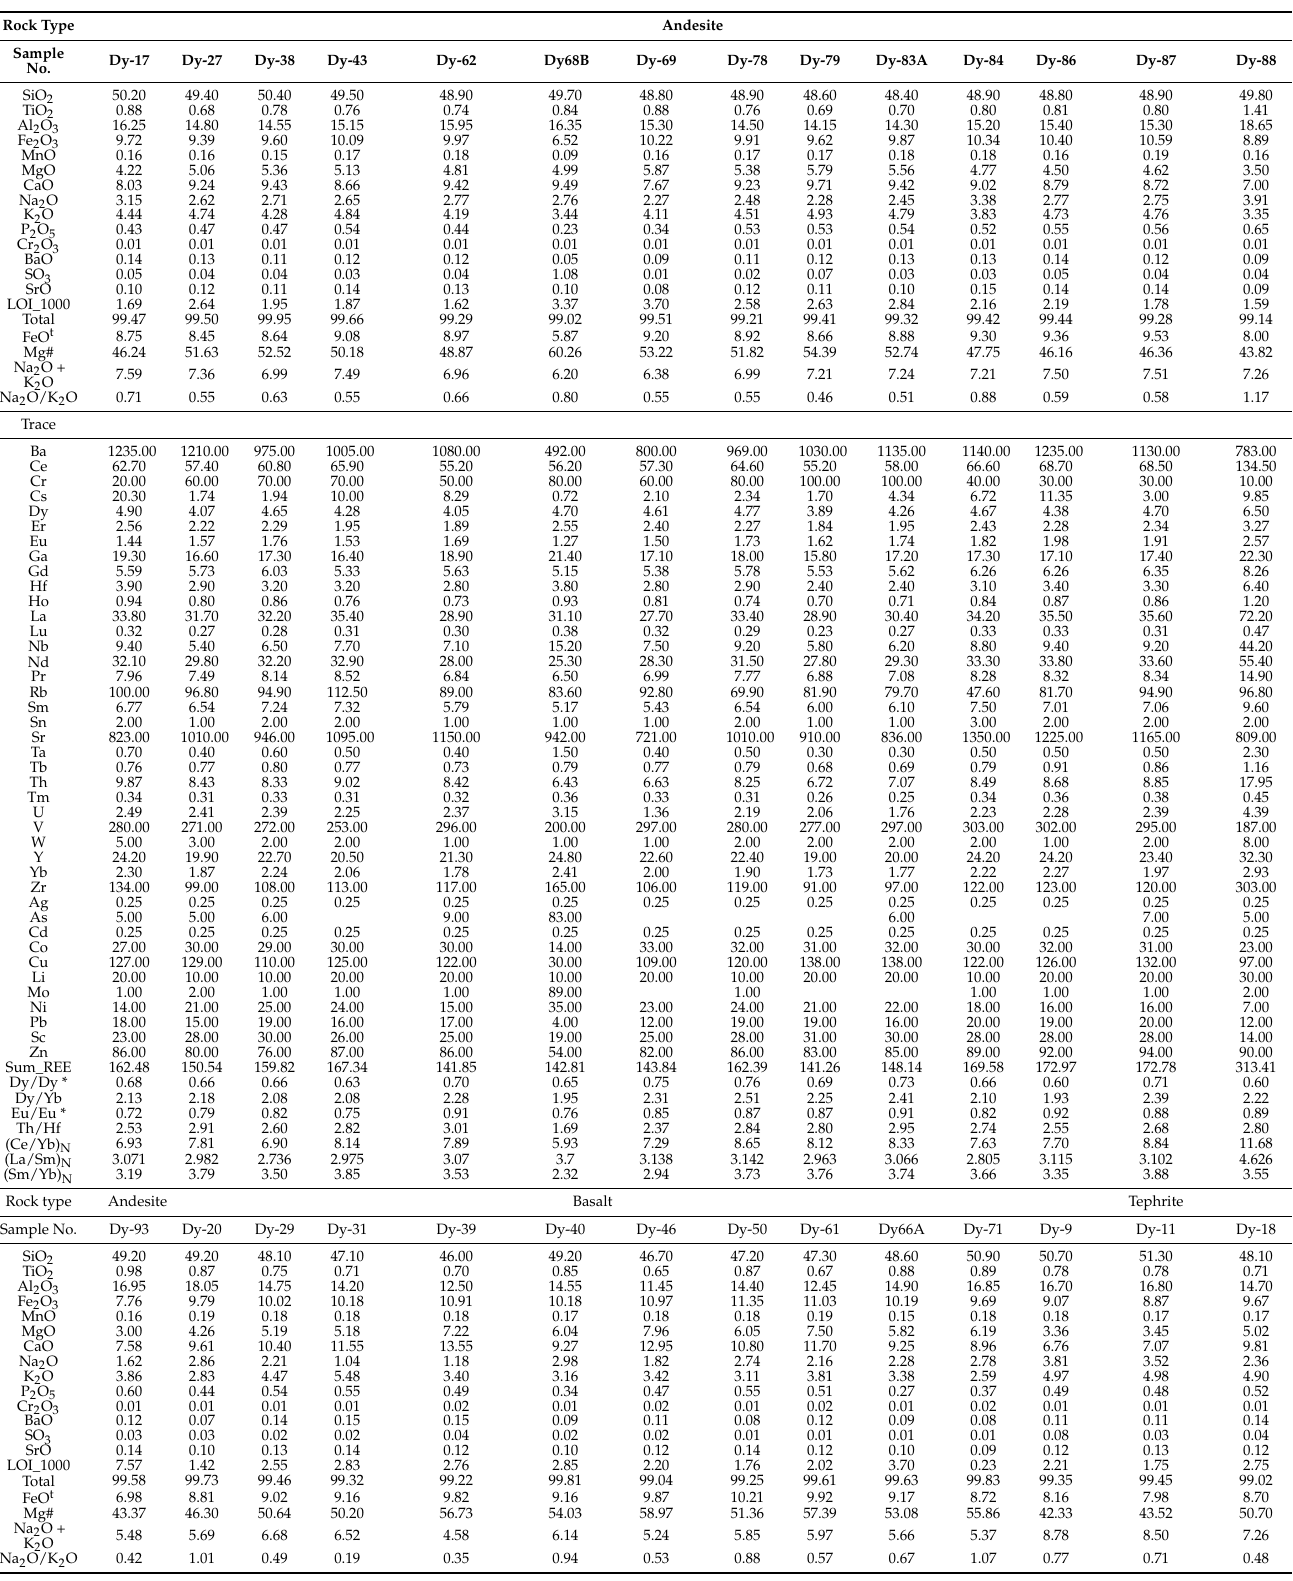
Table 1. Whole-rock major oxides (wt.%) and trace elements (ppm) of dyke swarms.